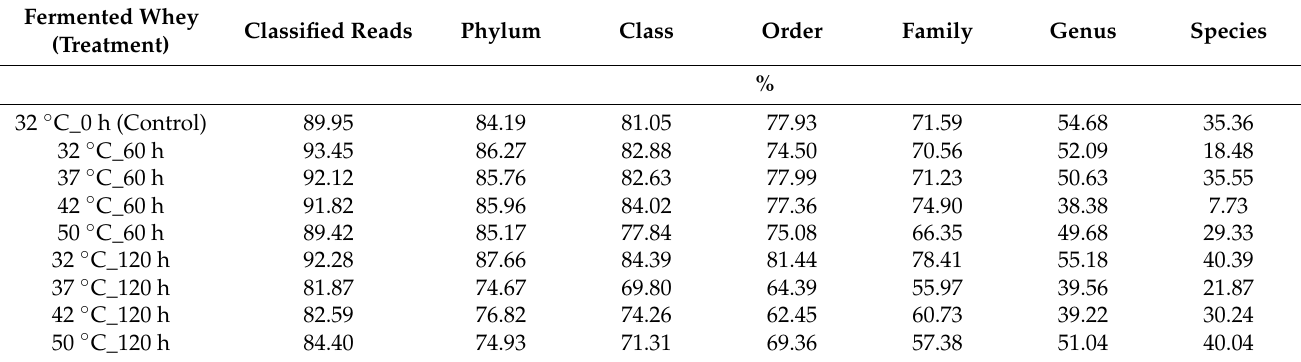
Table 2. Average abundance (%) of sequence assigned to taxa for all whey samples after 0, 60, and 120 h of spontaneous fermentation at 32, 37, 42, and 50 ◦